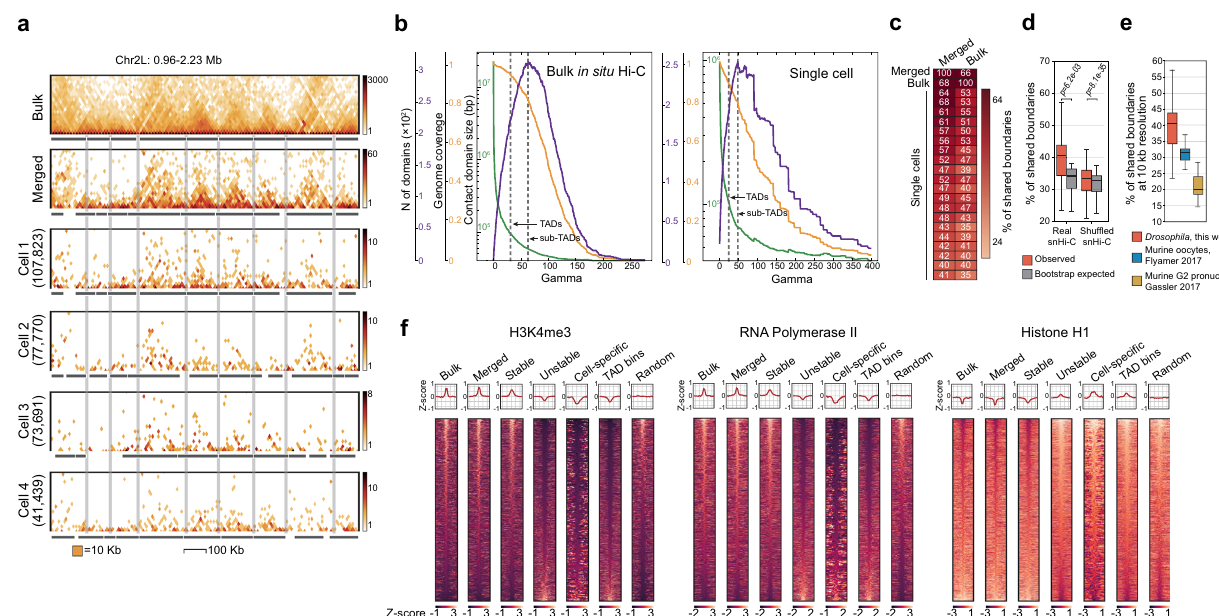
Fig. 3 Stable TAD boundaries are de fi ned by high level of active epigenetic marks. a Example of a genomic region on Chromosome 2L with a high similarity of TAD pro fi les (black rectangles) in individual cells and bulk BG3 in situ Hi-C data. Number of unique captured contacts is shown in brackets. Positions of TAD boundaries identi fi ed in bulk BG3 in situ Hi-C data (top panel) are highlighted with gray lines. Here and below, TADs are identi fi ed using lavaburst software. b Dependence of the contact domain (CD) size (green), genome coverage by CDs (orange), and number of identi fi ed CDs (violet) on the γ value in bulk (left) and single-cell (right) BG3 Hi-C data. γ values selected for the calling of sub-TADs ( γ max ) and TADs ( γ max /2) are marked with vertical gray lines. c Percentage of TAD boundaries shared between single cells, bulk BG3 in situ Hi-C, and merged snHi-C data. d Percentage of shared boundaries in real snHi-C, shuf fl ed control maps, and bootstrap expected. Boxplots represent the median, interquartile range, maximum and minimum. ** p < 0.01 using the Mann – Whitney two-sided test. n = 380 comparisons between individual cells. e Percentage of shared boundaries in real snHi-C for Drosophila , murine oocytes from Flyamer et al. 32 and G2 zygote pronuclei from Gassler et al. 34 . Boxplots represent the median, interquartile range, maximum and minimum. n = 380 comparisons between individual cells. f Heatmaps of active (H3K4me3, RNA Polymerase II) and inactive (H1 histone) chromatin marks centered at single-cell TAD boundaries from different groups (±100kb). Bulk — conventional BG3 in situ Hi-C; merged — aggregated snHi- C data from all individual cells; stable and unstable — boundaries found in more and in less than 50% of cells, respectively; cell-speci fi c — boundaries identi fi ed in any one individual cell; TAD bins — genomic bins from TAD interior; random — randomly selected genomic